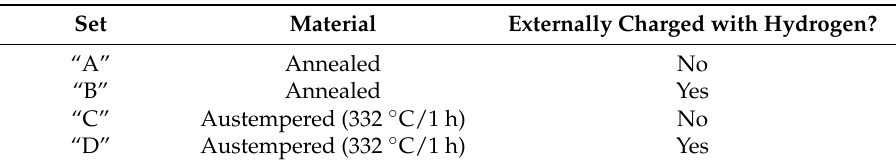
Table 2. Matrix of Material Conditions for the 4140 Alloy CT